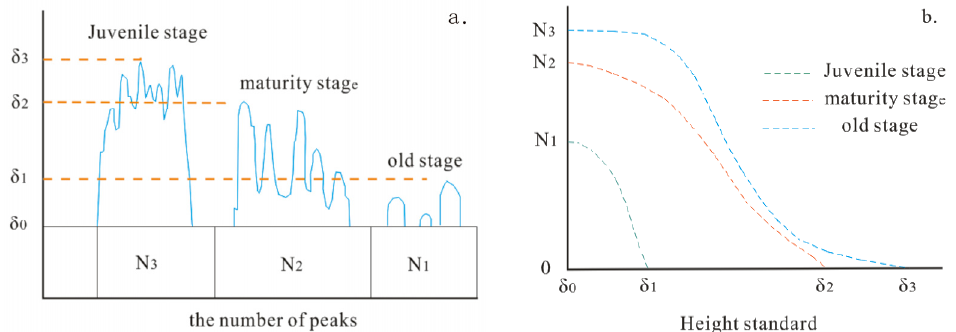
Figure 2. ( a ) Relationship between the number of Karst peaks and Karst development stages. ( b ) Relationship between the height standards and Karst development stages.